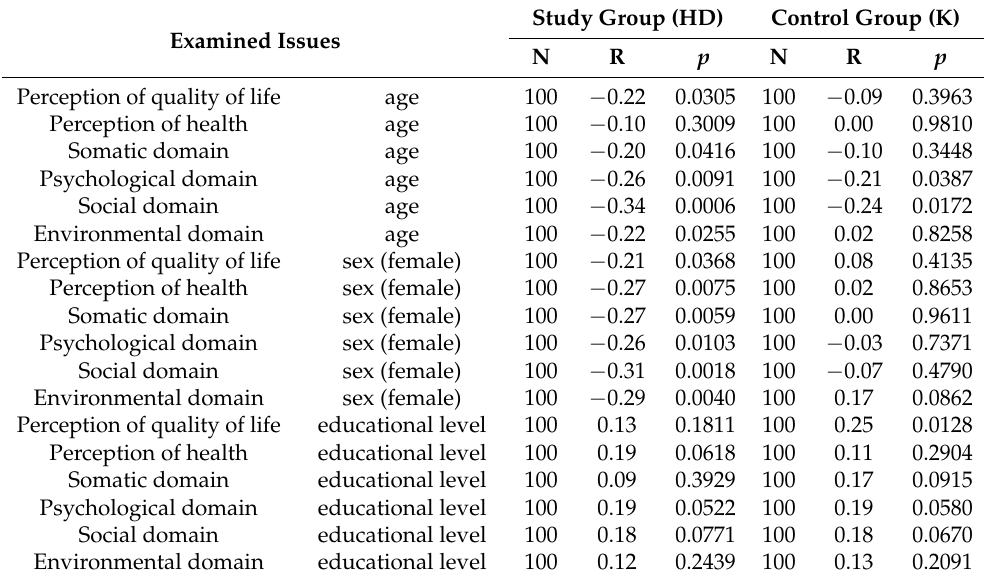
Table 4. The correlation between the examined domains of quality of life and age, gender, and level of education in the study group (HD) and control group (K).